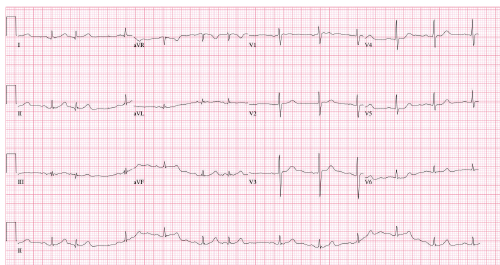
Figure 1: 12-lead EKG on admission showing normal sinus rhythm.